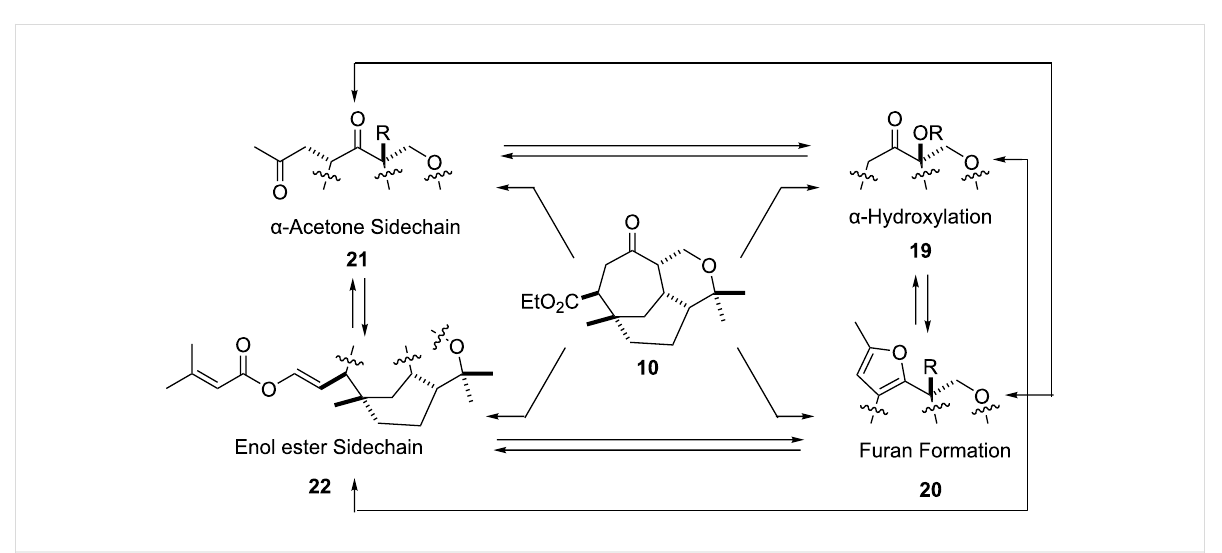
Scheme 2: The four functional group areas identified for